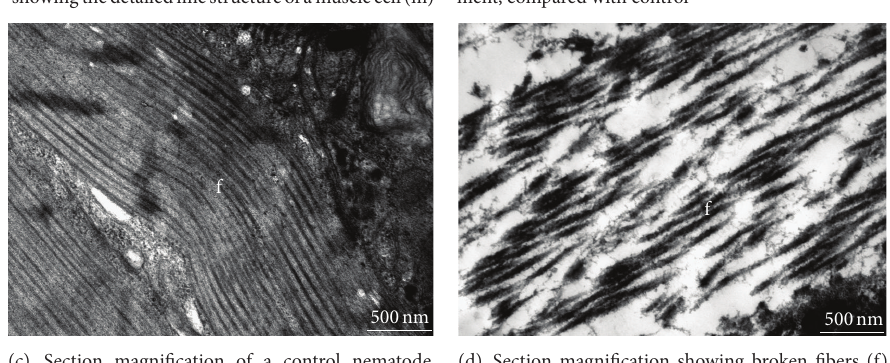
(c) Section magnification of a control nematode, (d) Section magnification showing broken fibers (f) showing tightly organized fibers (f) treated with chloroform extract Figure 4: Transmission electron micrographs of muscle and fibers of adult M.